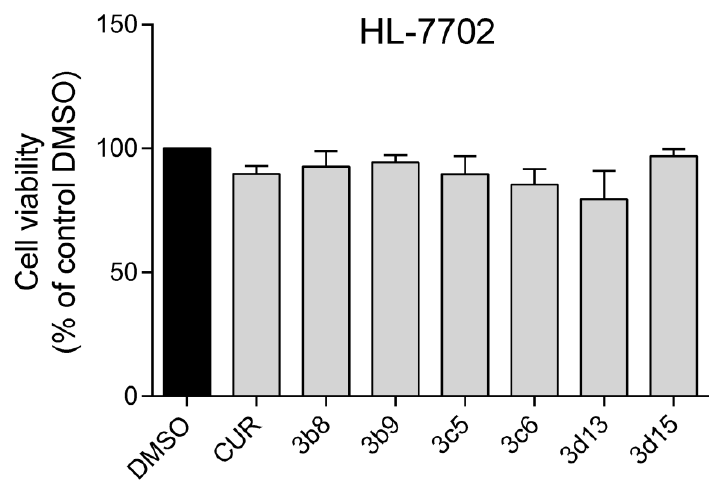
Figure 5. Effects of active compounds on human normal liver HL-7702 cells